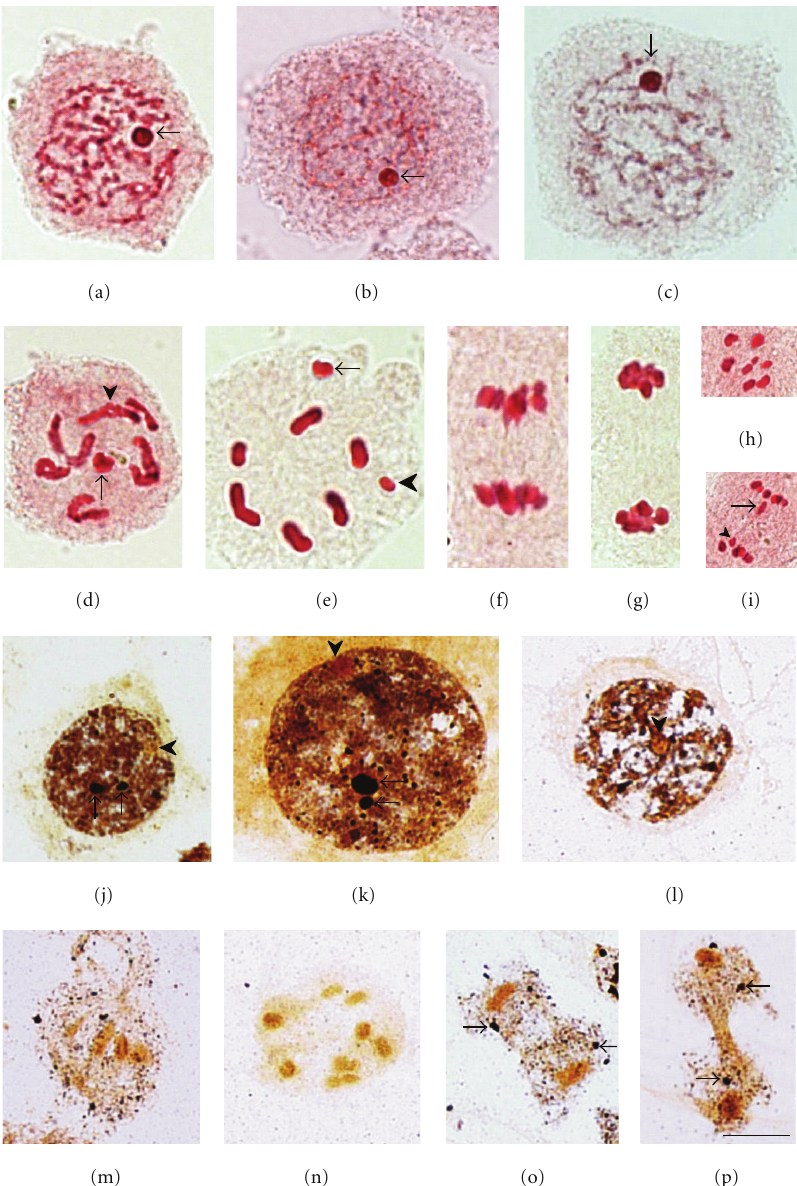
Figure 2: Meiotic cells stained with lacto-acetic orcein ((a)–(i)) and silver impregnated ((j)–(p)). ((a)–(c)) Early prophase I with heteropyknotic body in the periphery of the nucleus (arrows), with (a) belonging to lobes 1–3, (b) to 4 and 6 and (c) to 5; (d) diplotene/diakinesis showing a bivalent with interstitial chiasma (arrowhead) and heteropyknotic body (arrow); (e) final stage of diakinesis showing X and Y chromosome, respectively, arrow and arrowhead; ((f), (g)) anaphase/telophase I with regular segregation of chromosomes; (h) metaphase II showing the autosomes arranged in ring-shape and the sex chromosomes in the center; (i) anaphase/telophase II with lagging migration of the X chromosome (arrow) and the Y chromosome in the opposite part of the cell (arrowhead); ((j)–(l)) early prophases I showing two round silver-positive bodies (arrows) that are disorganized during the subsequent phases and one body less impregnated (arrowheads). Note that in prophase of lobes 4 and 6 (k), there are several silver-positive bodies scattered throughout the nucleus; (m), (n)) metaphase I with silver impregnation in the cytoplasm and chromosomes (m), di ff ering from lobe 5, which has silver-negative metaphase (n); ((o), (p)) telophase II with nucleolar reorganization in both cell formations (arrows). Bar = 10 µ